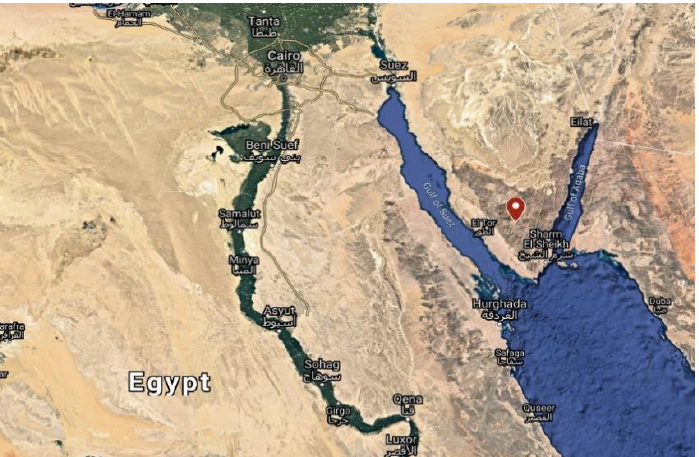
Figure 9. Geography of sampling sites for Actinobacteria isolation from the Sinai desert, south of the Sinai Governorate, Egypt (red spot). This map is retrieved from the satellite map of Egypt (https://www.google.com/maps/. Accessed on: 1 January 2021).